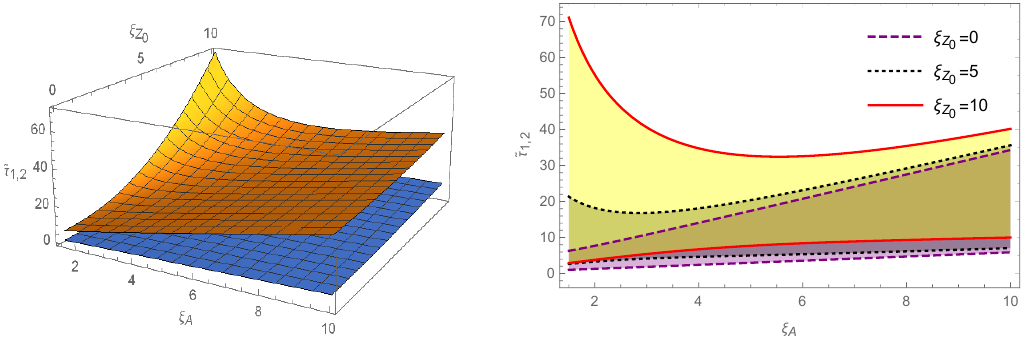
. (Right) three 0 = 0 in (dashed) purple, (cid:24) Z = 5 in 0 0